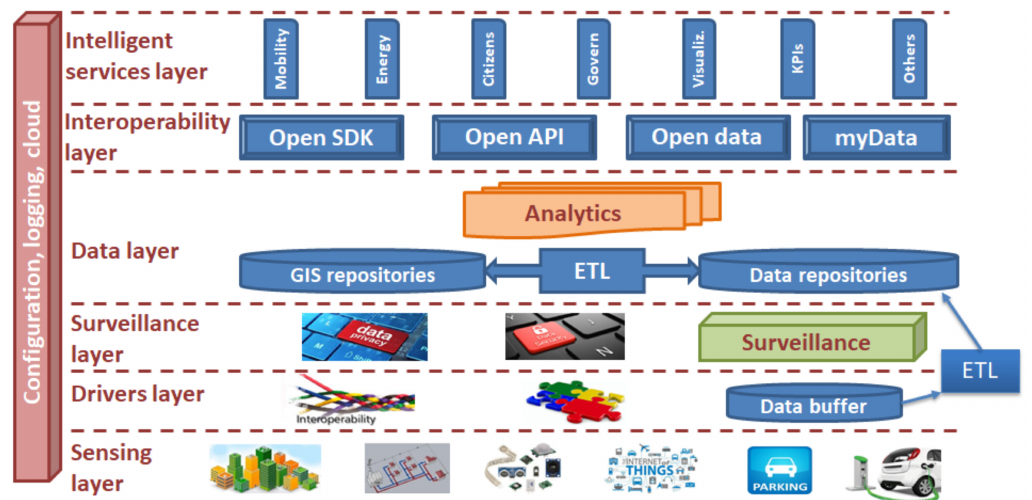
Figure 3. mySMARTLife proposed Open Specifications